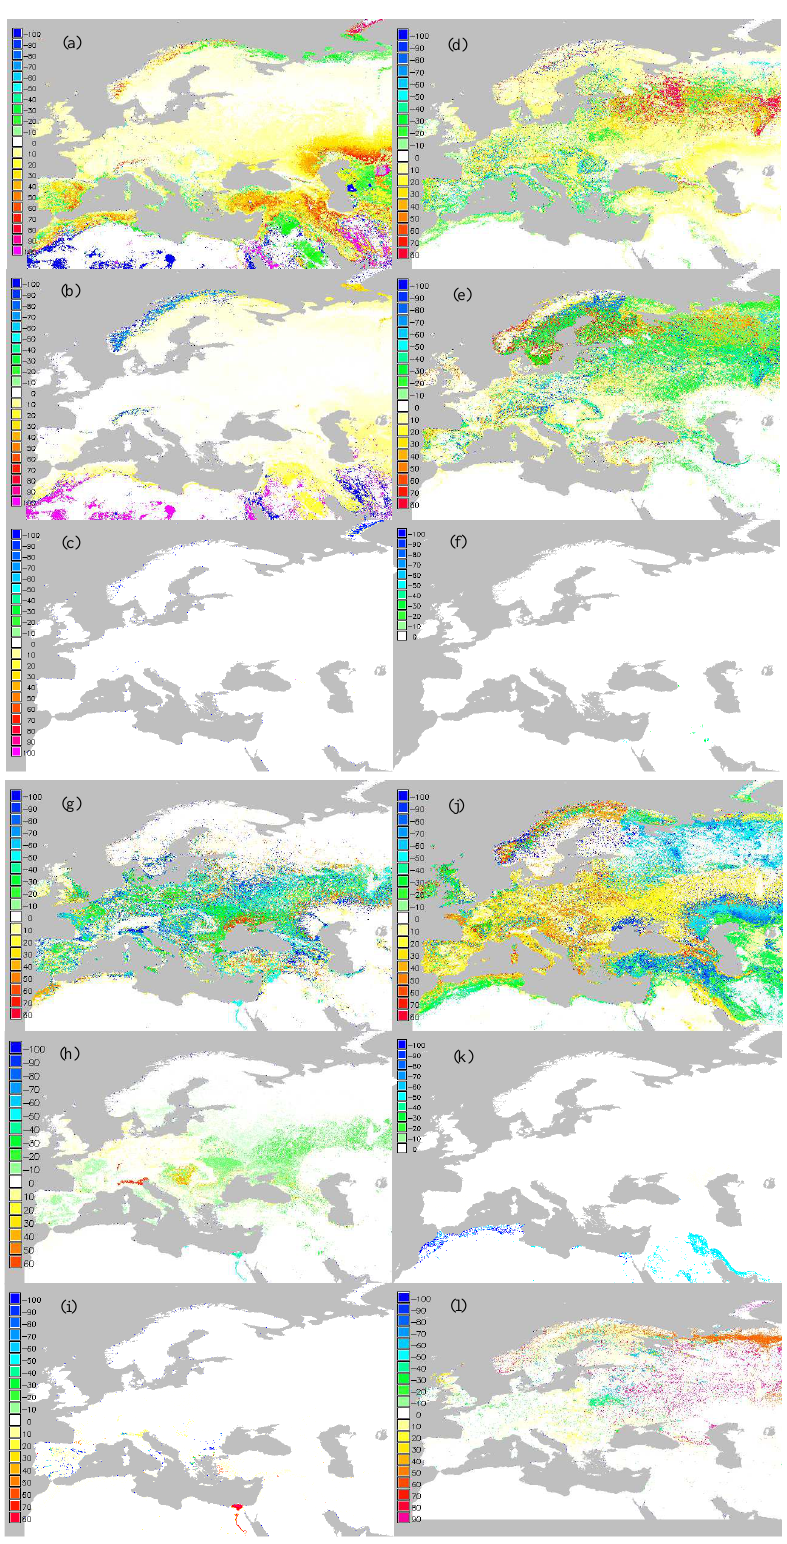
Fig. 9. Comparison of ECOCLIMAP-II and ECOCLIMAP-I fractions of vegetation types: (a) bare land, (b) bare rock, (c) snow, (d) deciduous broadleaved forest, (e) needle-leaved forest, (f) evergreen broadleaved forest, (g) C3 crops, (h) C4 crops, (i) irrigated crops, (j) temperate grasslands, (k) tropical grasslands and (l) wetlands. 20